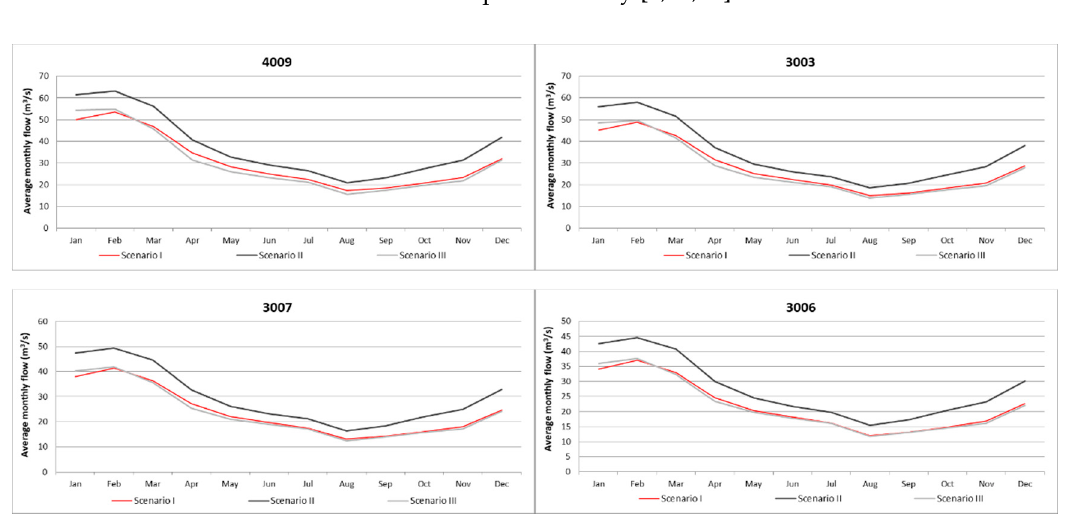
Figure 6. Average monthly flow (1990–2016) at the four hydrometric stations for each land use scenario.